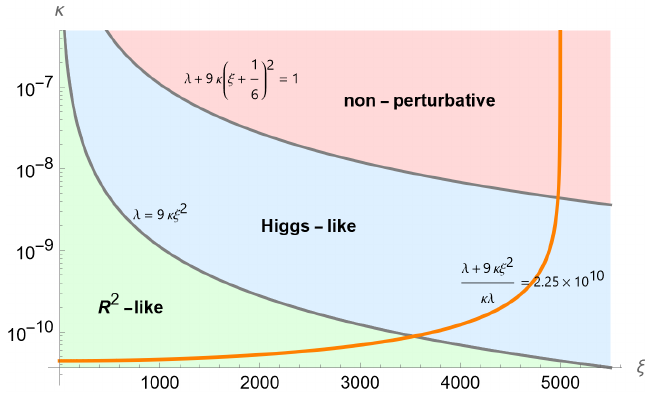
Figure 1 . Consistent inflation for the parameter space in ( ξ, κ ) . The red region shows the strong coupling regime. The blue and green regions correspond to the Higgs-like inflation (with 9 κξ 2 > λ ) and the R 2 -like inflation (with 9 κξ 2 < λ ), respectively. The orange line satisfies the CMB normalization (2.20). We set λ = 0 . 01